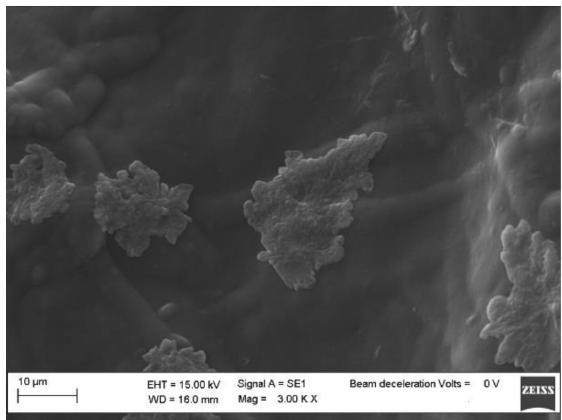
Figure 7. SEM micrograph of the BC–IL-CP surface.